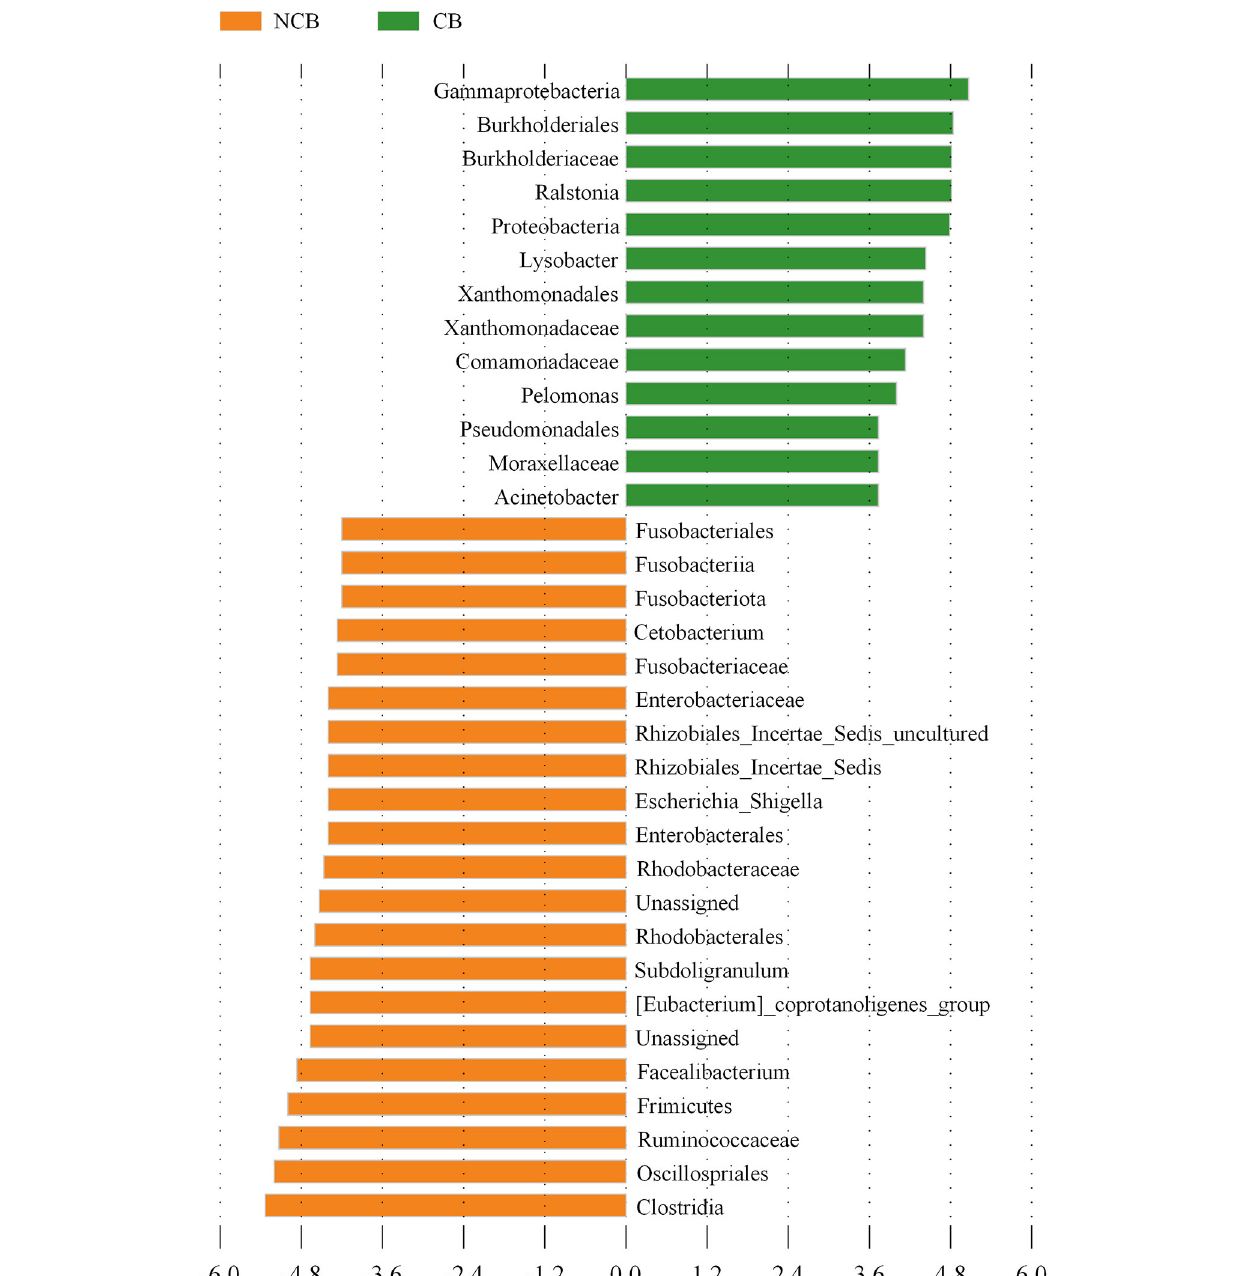
analysis (LDA) coupled with effect size (LEfSe) (http:// huttenhower.sph.harvard.edu/galaxy) ( Segata et al., 2011).